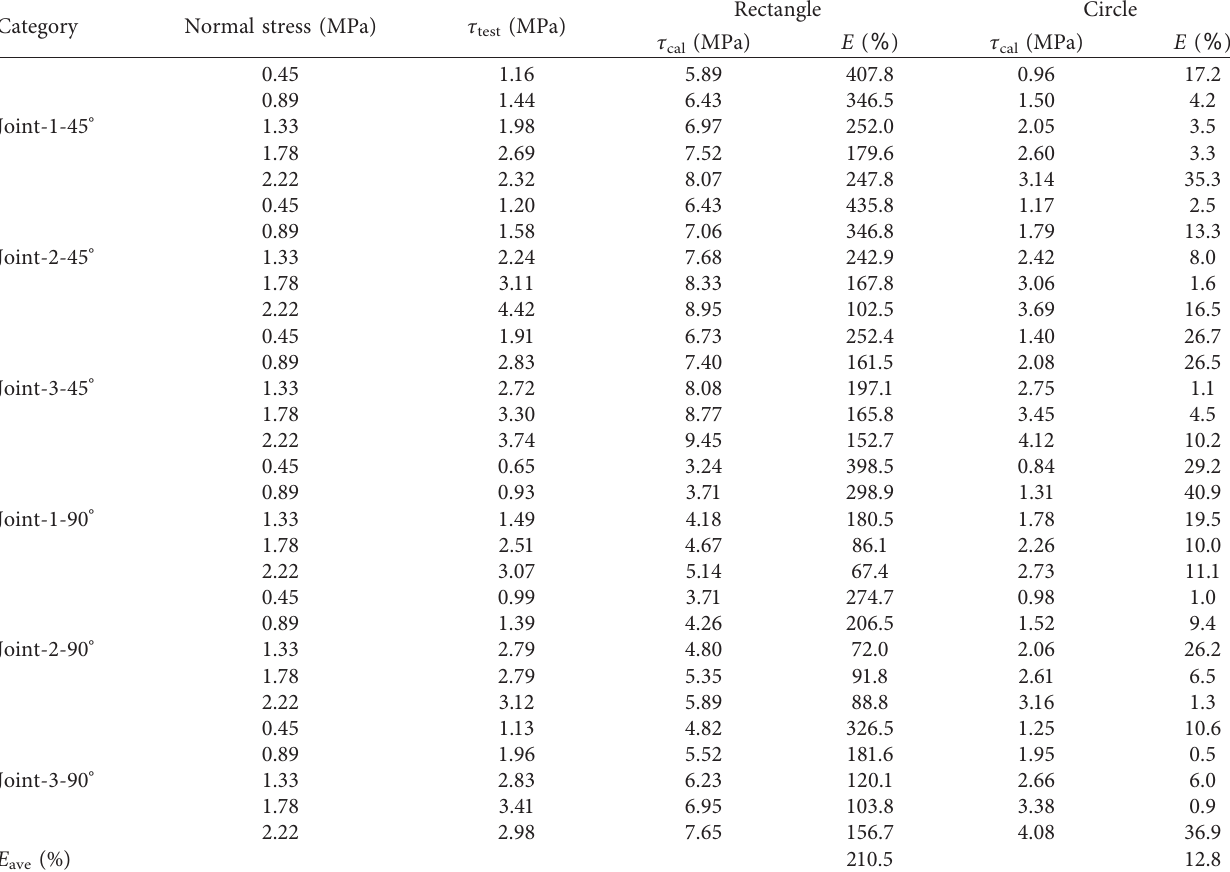
Table 4: Comparison between calculated and measured values of shear strength of the two